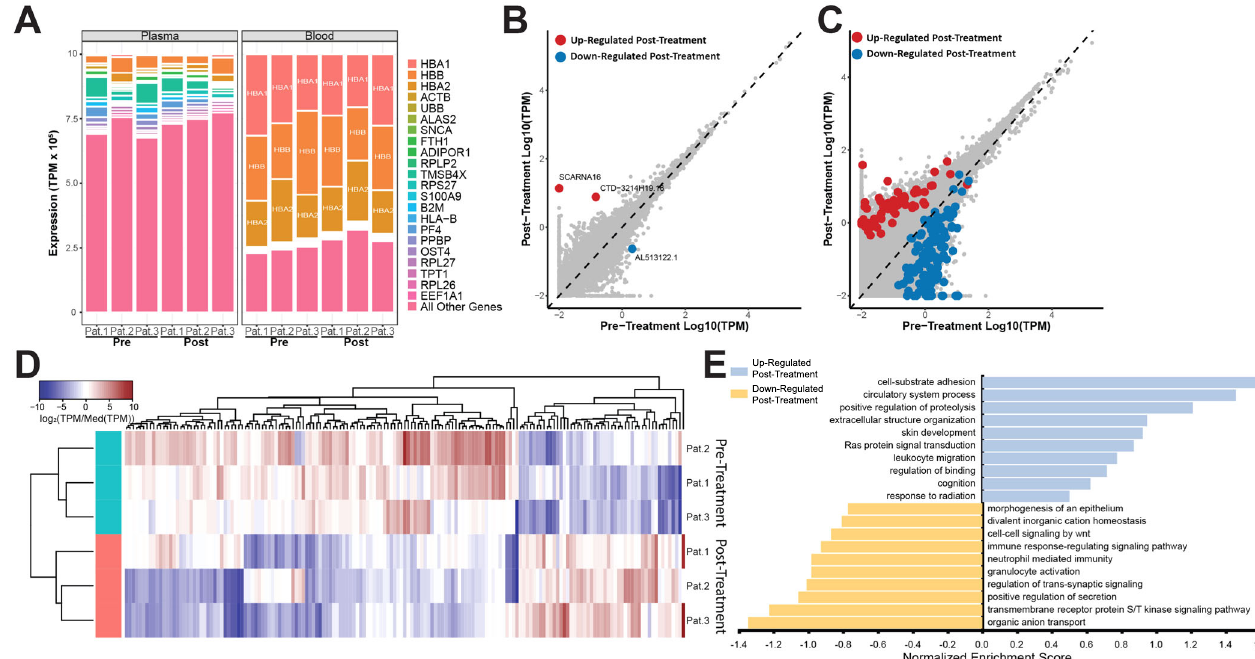
Fig. 2 Differential gene expression analysis in plasma is more informative than in whole blood samples from ICP patients. A Stacked bar graphs showing the expression (in TPM) of the ten most abundant detected genes in individual plasma and whole blood samples. Pink bars on the bottom represent abundance of all other genes detected. B Scatterplot of all genes detected in pre- and post- treatment whole blood samples. Genes that are signi fi cantly up-regulated (p-adj. (Benjamini-Hochberg) < 0.05) in post-treatment samples are shown in red, genes that are signi fi cantly down-regulated (p-adj. (Benjamini-Hochberg < 0.05) in post-treatment samples are shown in blue. C Scatterplot of all genes detected in pre- and post- treatment plasma samples. Genes that are signi fi cantly up-regulated (p-adj. (Benjamini-Hochberg) < 0.05) in post-treatment samples are shown in red, genes that are signi fi cantly down-regulated (p-adj. (Benjamini-Hochberg < 0.05) in post-treatment samples are shown in blue. D Heatmap showing differential expression of signi fi cantly differentially expressed genes (p-adj. (Benjamini- Hochberg) < 0.05) between pre-treatment (teal) and post-treatment (salmon) plasma samples of three high-ICP patients. E Gene set enrichment analysis of gene expression in pre- vs. post-treatment high-ICP plasma patient samples (p-adj. (Benjamini-Hochberg) <